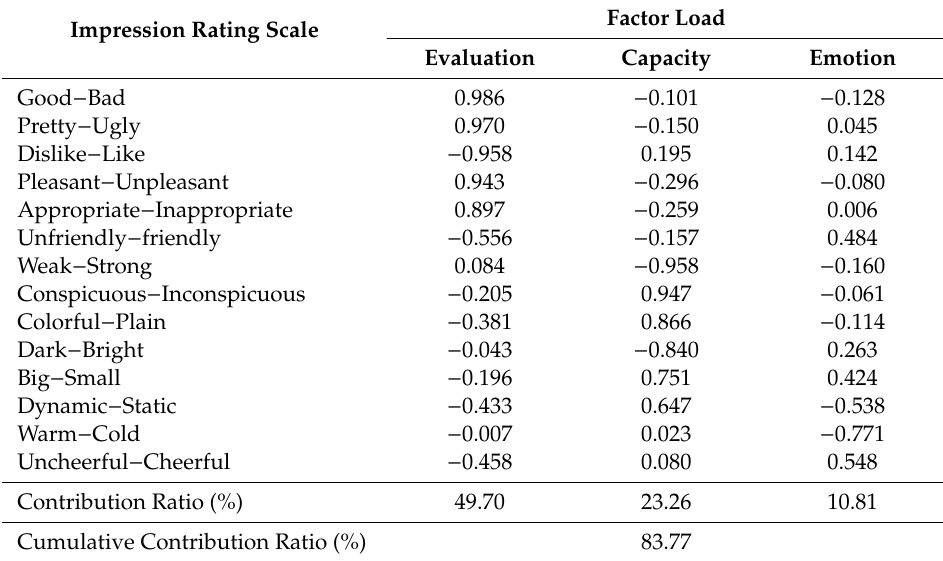
Table 6. Japanese factor